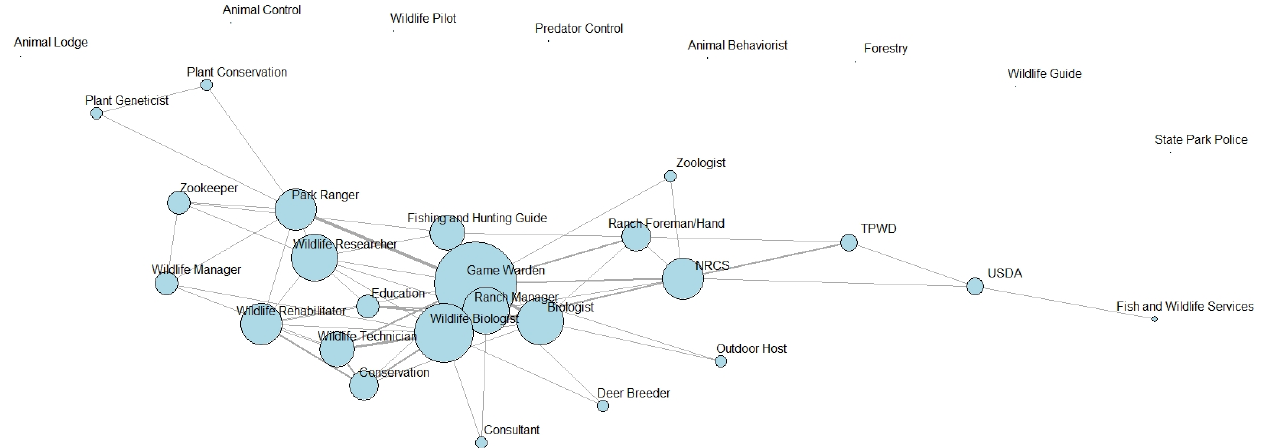
Figure 2. Network of career choices most reported (larger vertices) and co-occurrence of career choices (connecting lines) with bolder lines representing careers more frequently reported together on the post-survey from students at Texas A&M University-Kingsville, Kingsville, TX, USA in Fall 2016. Note: Unconnected careers represent those mentioned on the pre-survey yet were not reported by any student on the post-survey. NRCS, Natural Resources Conservation Service; TPWD, Texas Parks and Wildlife Department; USDA, United States Department of Agriculture.